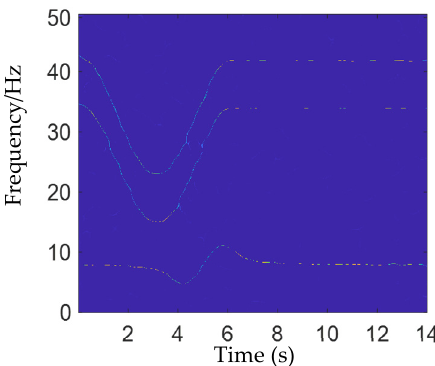
Figure 8. TF distribution of the simulated signal with noise based on RSECT.